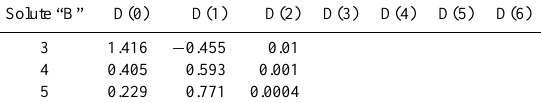
Table 7. Polynomials representing interactions between so- lute “A” (compound ’1’ in Table 1) and solutes “B” (com- pounds 3, 4 and 5 in Table 1), for a specific concentration of water as “B” changes; (β B , A (x 0 x 0 .. [ order = polynomial order ] B order − 1